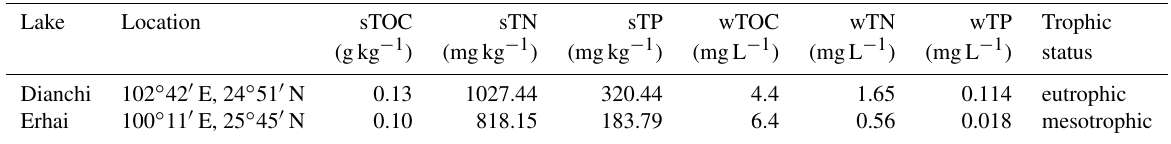
Table 1. Characteristics and trophic status of Dianchi Lake and Erhai Lake. sTOC, sTN, sTP and wTOC, wTN, wTP refer to average levels of total organic carbon (TOC), total nitrogen (TN), and total phosphorus (TP) of sediment and water, respectively. The locations of sampling sites were as illustrated in the literature (Yang et al., 2016).